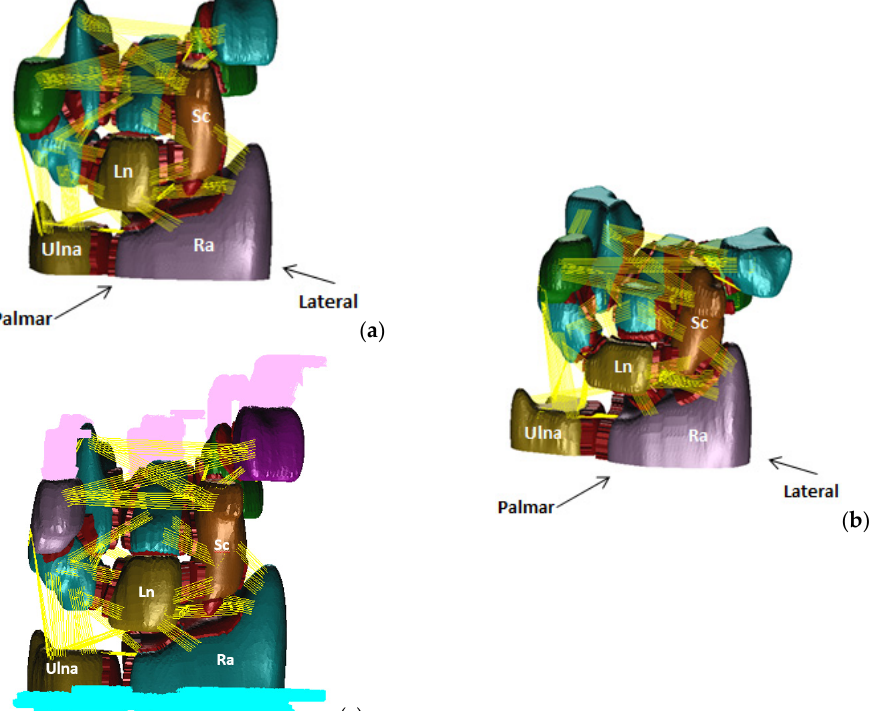
Figure 2. Finite element (FE) model of the right wrist of a healthy 40-year-old woman. Volar view of the carpal bones, cartilage elements at the articulations and ligaments in wrist posture of ( a ) extension and ( b ) radial extension. Different colors are applied to the different components in order to allow better visual differentiation. Moreover, ( c ) the loads and constrains on the model.